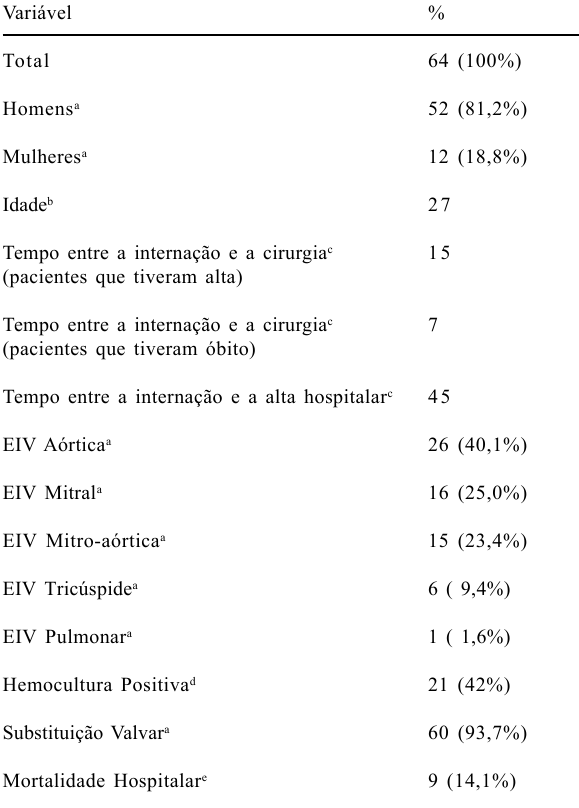
Tabela 1. Principais características clínico-laboratoriais e evolutivas